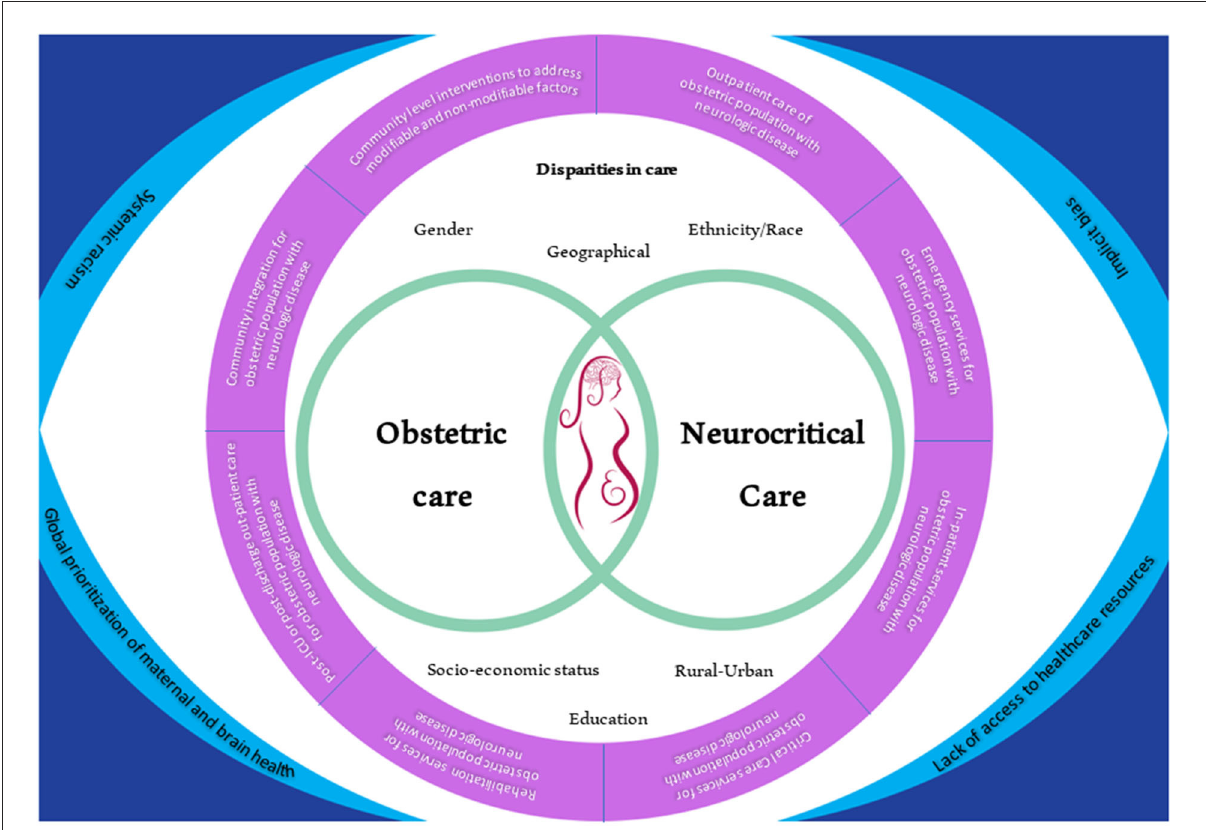
FIGURE1 A new lens into looking at the landscape of disparities in obstetric neurocritical care and its integration into the patient continuum of care. On the corners are the main issues that are prevalent and that have to be integrated across the continuum of care. All of these issues also affect both obstetric care and neurocritical care and ultimately affect the outcome of the mother and the fetus. The areas of disparities in care that should be considered through the care of these patients are also